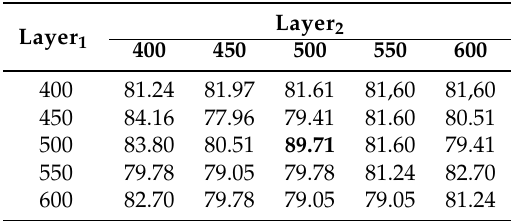
Table 9. Average classification accuracy results for an RBM with two hidden layers using a fine grid search around 500 neurons and the AAhydro set.